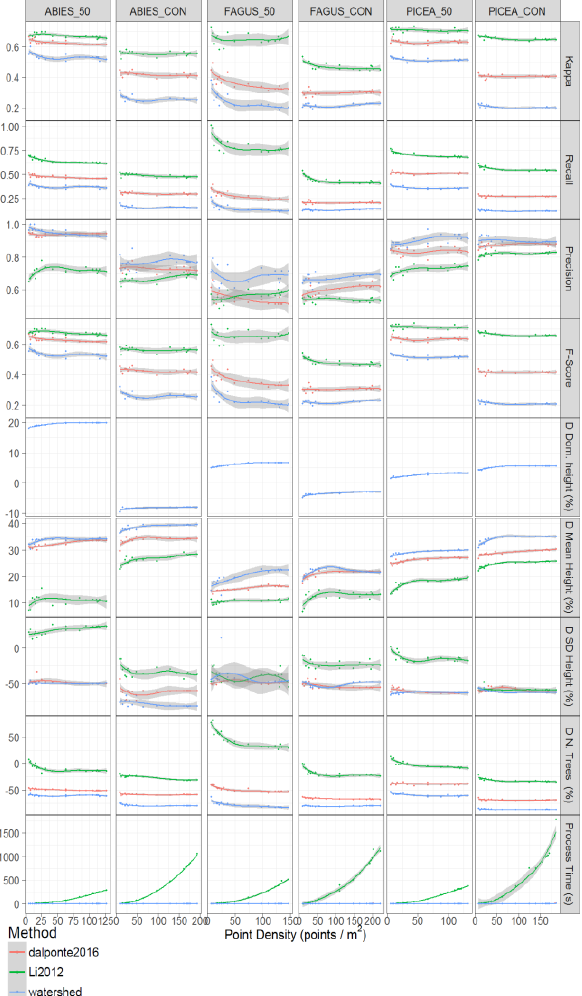
Figure 3. Accuracy metrics and processing time at different point densities and for different plots – more details in table 3 – processing time is in